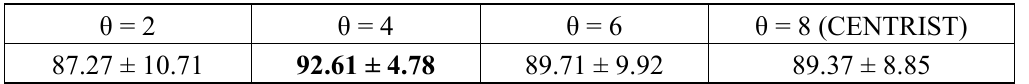
Table 2. Overall classification results using SVMs and different uniformity thresholds. We show the average and standard deviations over 10 experiments.